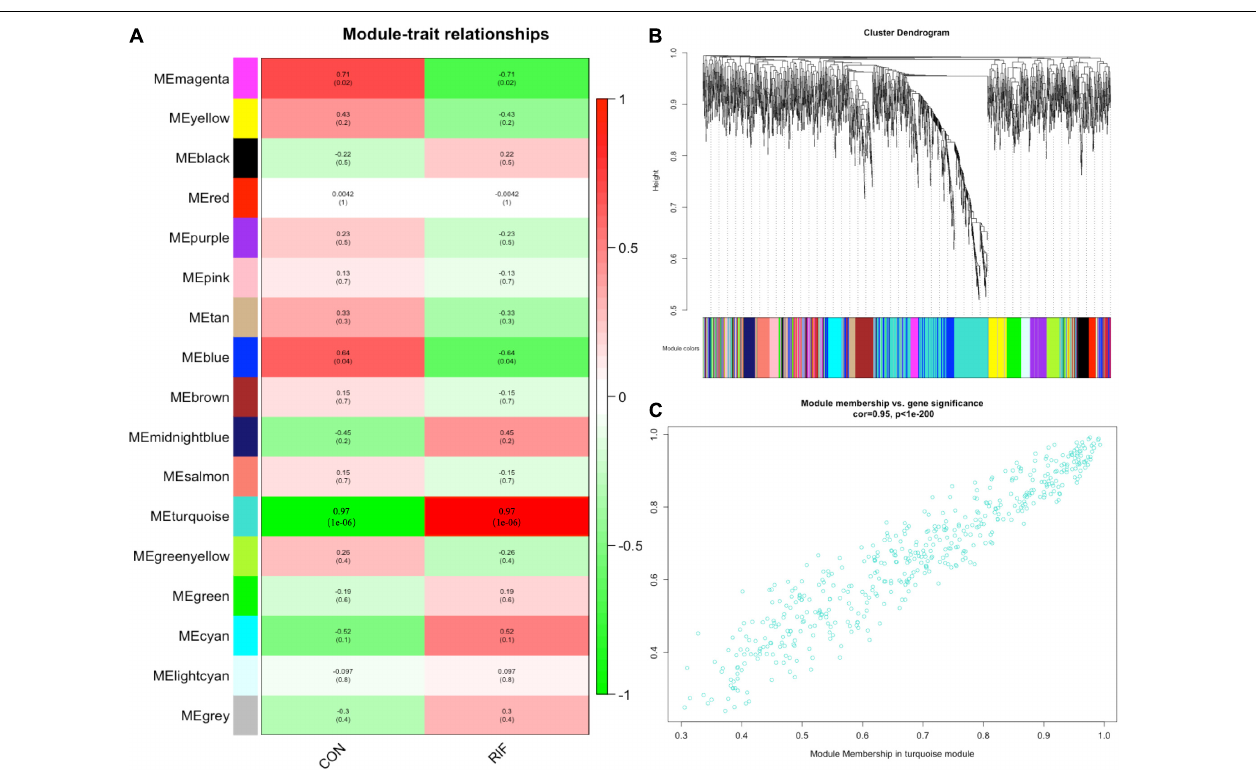
Frontiers in Genetics |